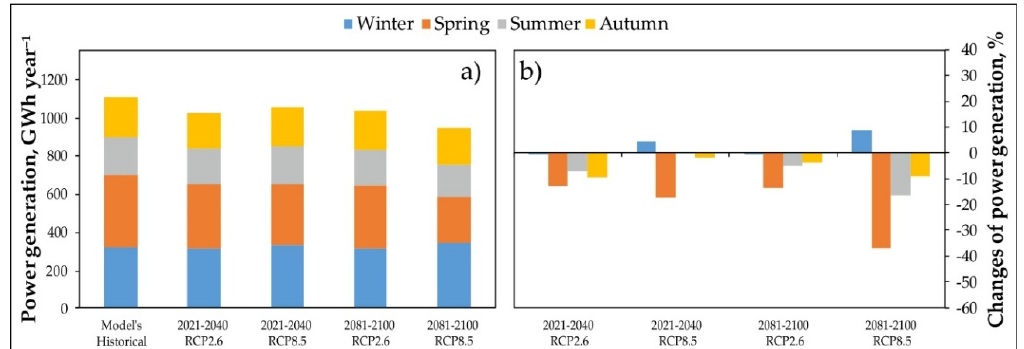
Figure 7. Projection of seasonal kinetic resources of the Nemunas and Neris revers in the near and far future ( a ) and their change compared to 1986–2005 ( b ).